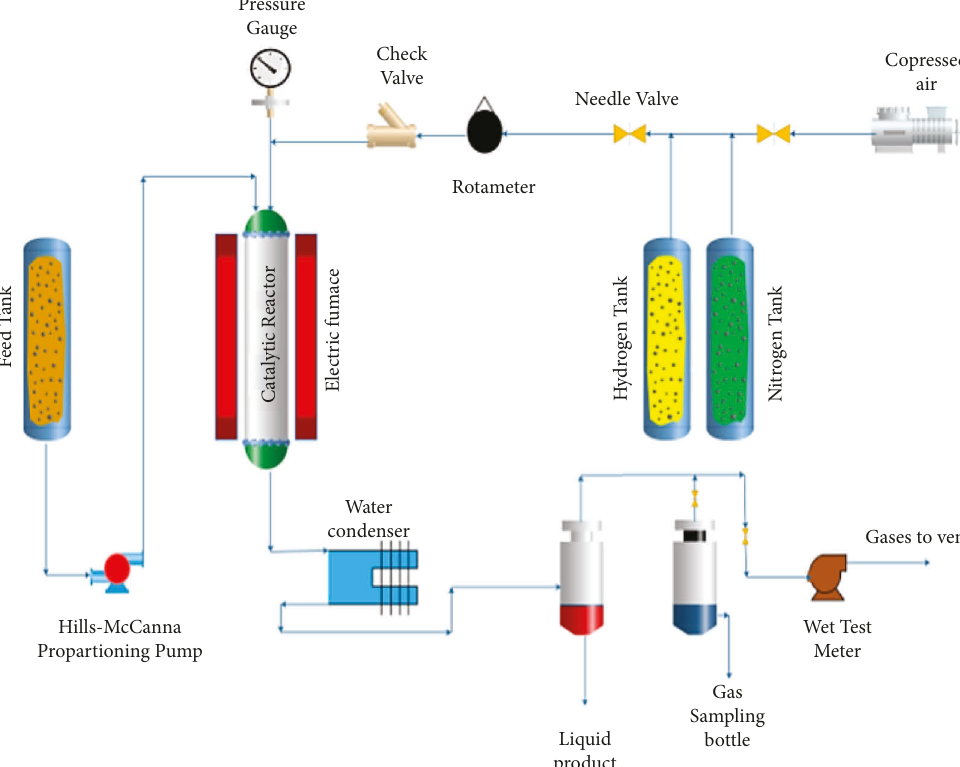
Figure 1: Diagram of the equipment for dehydrogenation of 2-butyl alcohol